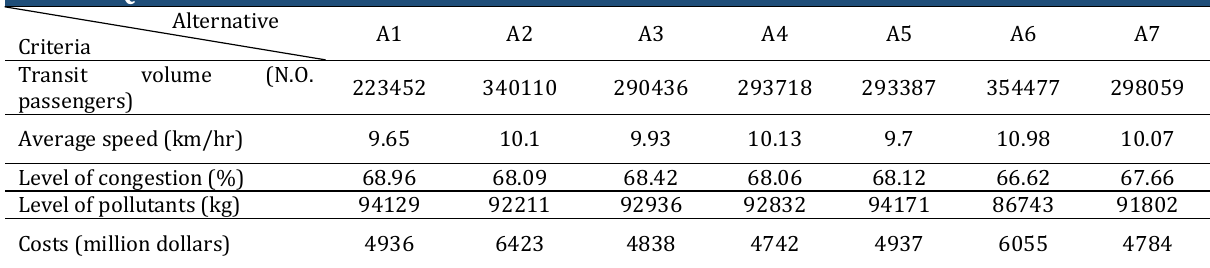
Table 2: Quantitative values of criteria in each